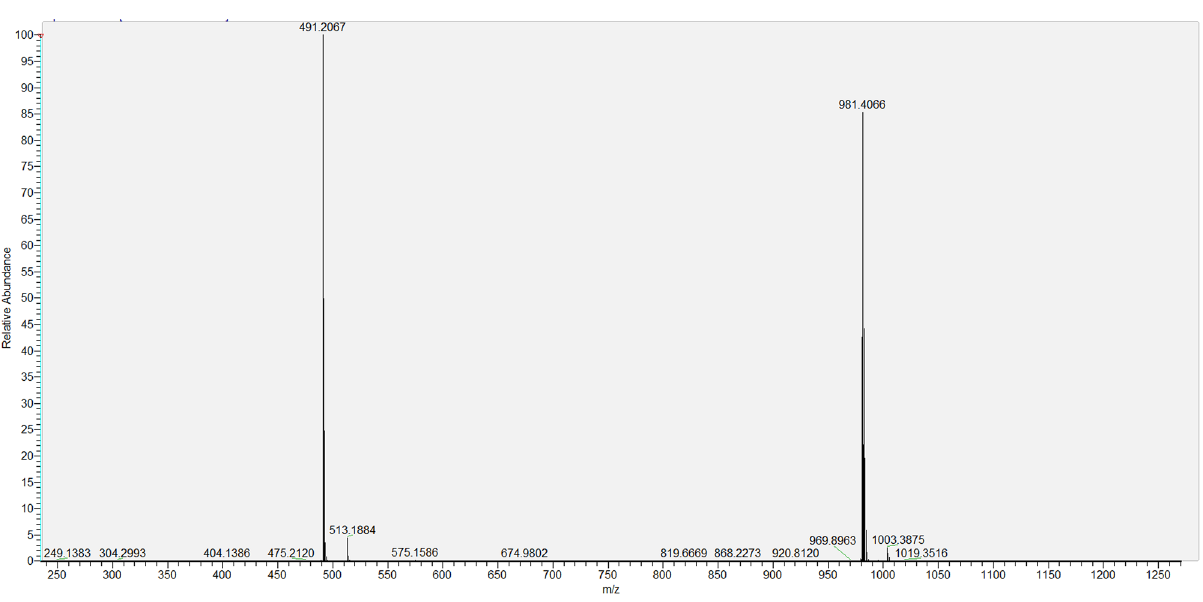
Figure 7. HRESIMS of Sildenafil N-oxide in the positive